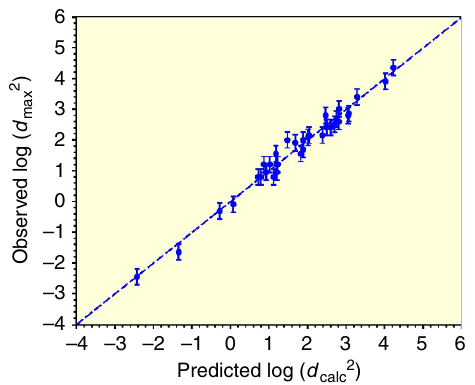
Figure 3 | Correlation between observed log ( d max 2 ) and predicted log ( d calc 2 ). Values of log( d calc 2 ) are obtained from t rg and m using equation (2). Dashed line is the result of a linear regression least squares fit with fitting parameters log ð d 2 10.36, L t ¼ 25.6 and L m ¼ 0.0481. The max ; 0 Þ¼ (cid:2) coefficient of determination for the linear fit is R 2 is 0.980. Error bars given by equation (3) in